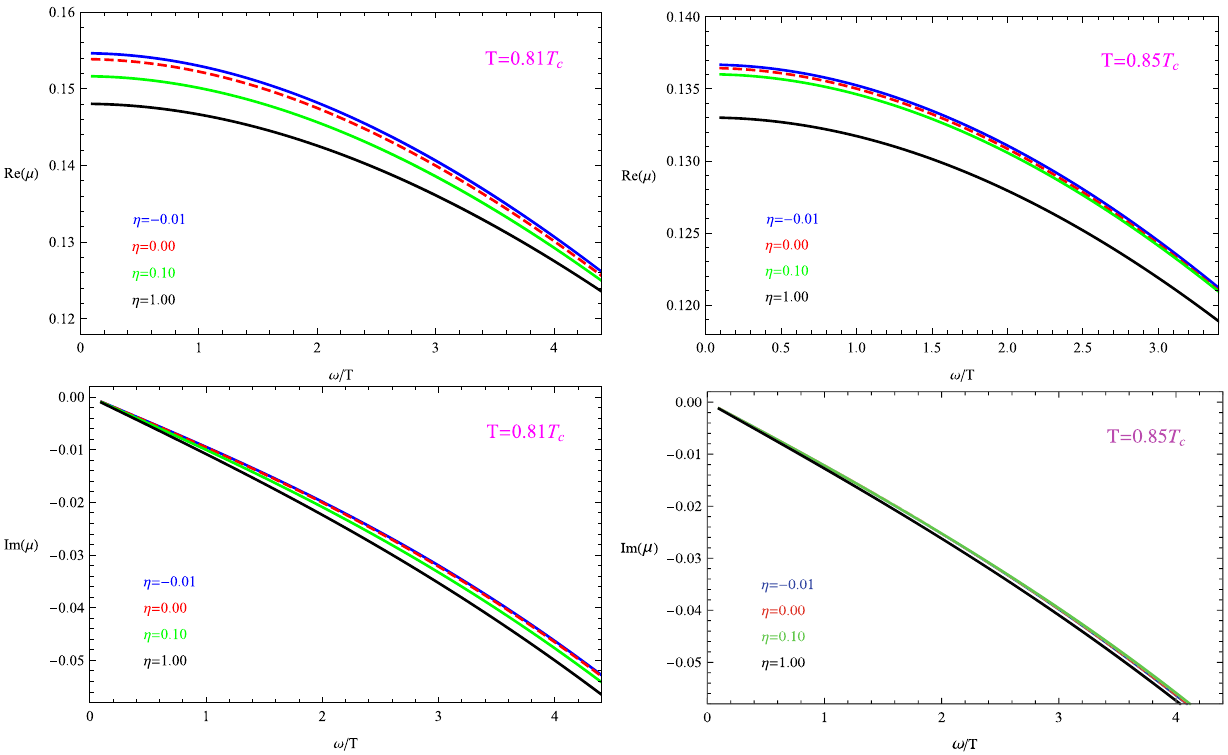
Fig. 9 Real (top) and imaginary (bottom) parts of the permeability μ as a function of ω/ T with the fixed temperatures T = 0 . 81 T c (left) and T = 0 . 85 T c (right) for different values of the coupling parameter,